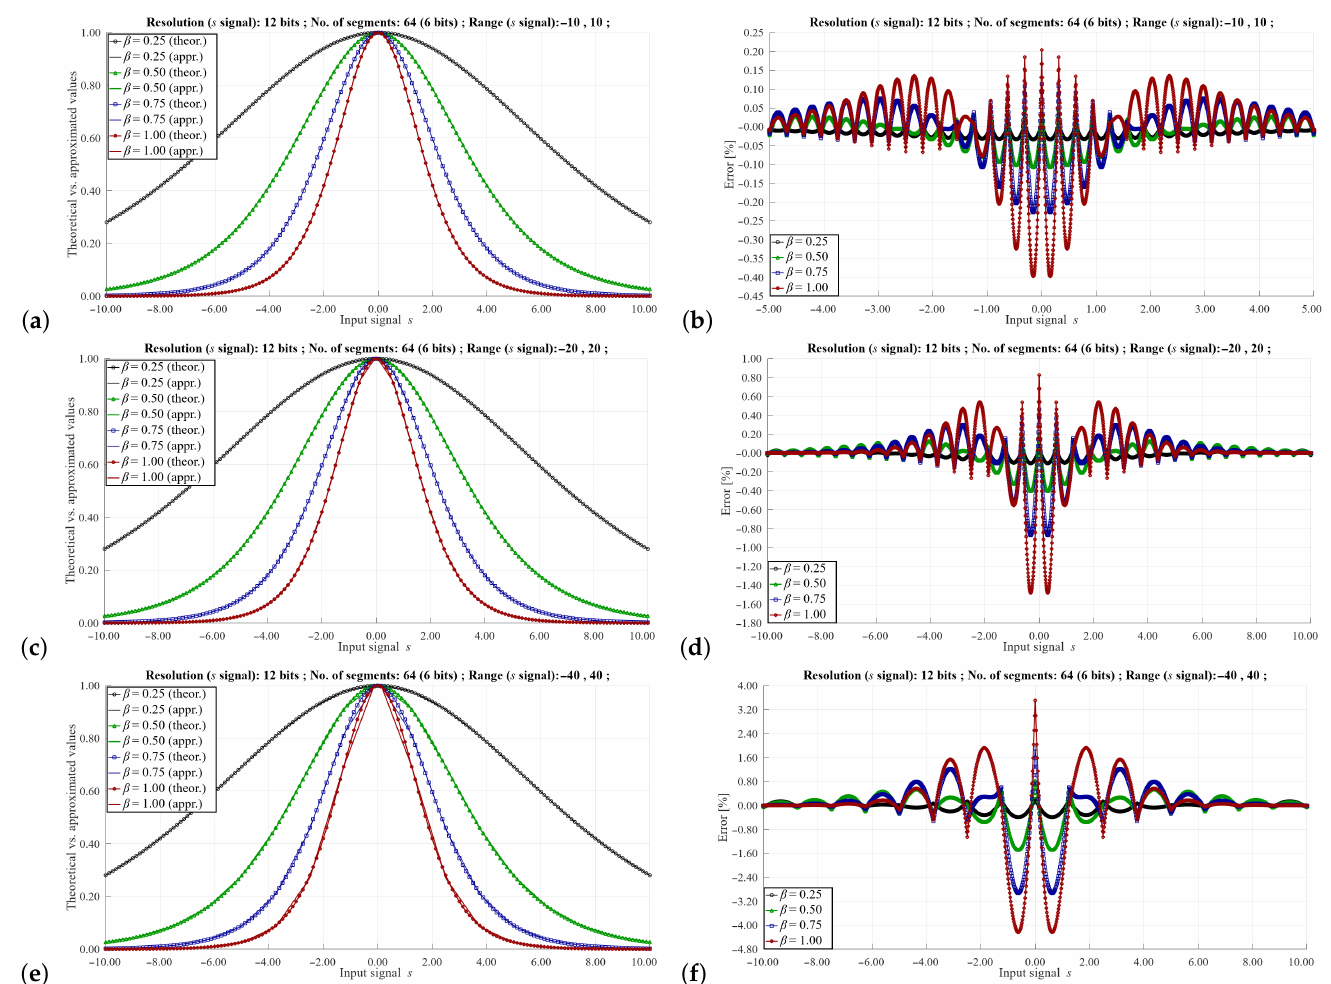
Figure 7. Approximation of the Λ ( s ) function for the s signal coded on 12-bits, for 64 segments (6-bits), for the range ( a , b ) − 10 , 10, ( c , d ) − 20, 20 and ( e , f ) − 40, 40. Meaning of diagrams in the left and right columns as in Figure